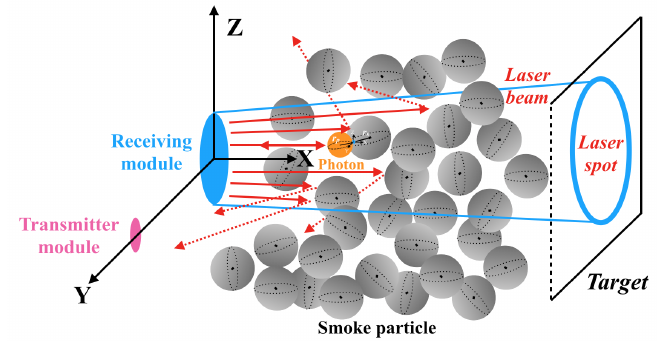
Figure 8. Photon motion process based on reverse